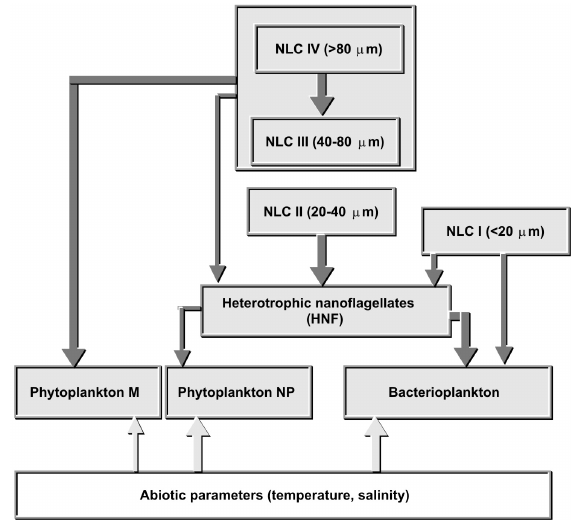
F IG . 9. – Schematic review of direct relationships between the abi- otic and some biotic parameters within the microbial food web in the eastern part of the Kas ˇ tela Bay obtained using Pearson’s corre- lations, Multiple regression analysis and Principal component analysis (Phy NP, nano- and pico-phytoplankton fraction; Phy M, microphytoplankton fraction; NLC, nonloricate ciliates, I<10 3 µm 3